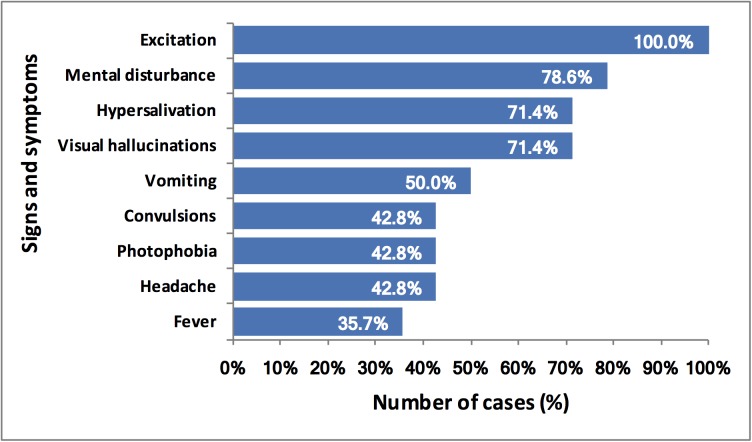
Frequency of signs and symptoms in cases of human rabies.